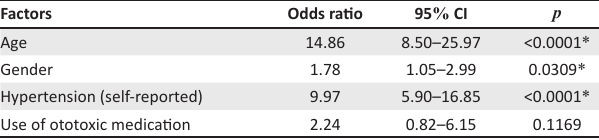
were age, gender and a self-reported history of hypertension. TABLE 5: Factors associated with disabling hearing impairment.